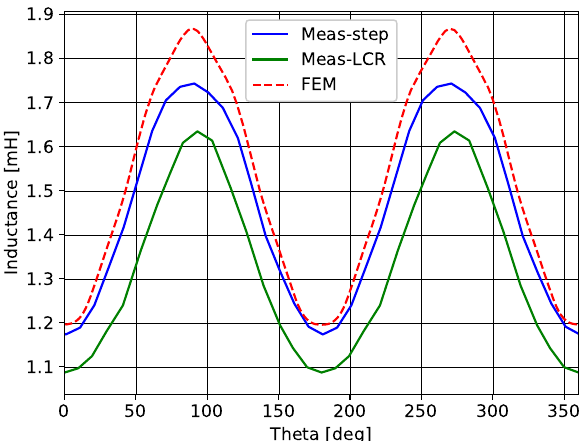
Figure 12. Inductance versus electrical position by FEA and two different measurement methods.